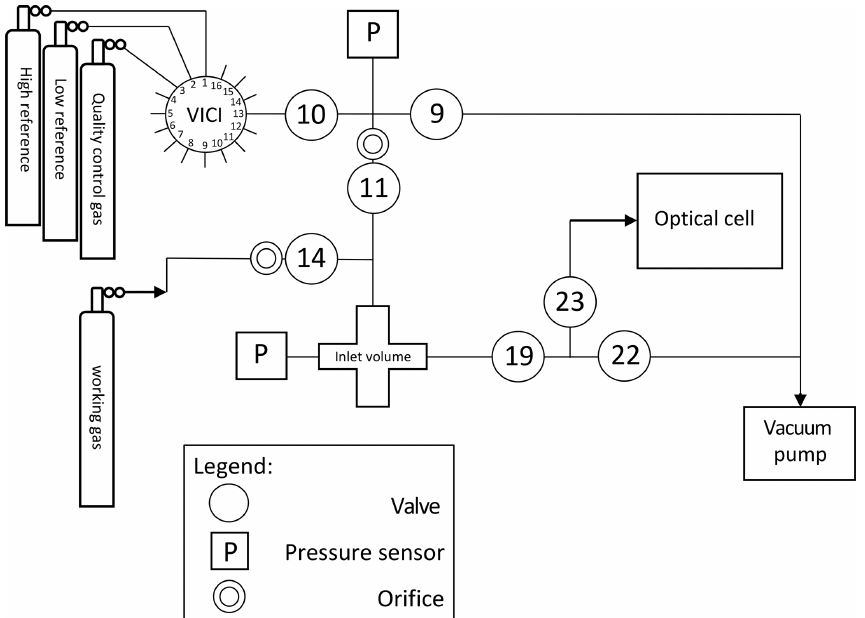
Figure 3. Gas inlet system of the SICAS with one VICI multi-valve inlet port, connected to three high-pressure natural-air tanks and 12 free ports for samples. The includes an extra inlet port for the working gas, also a high-pressure natural-air